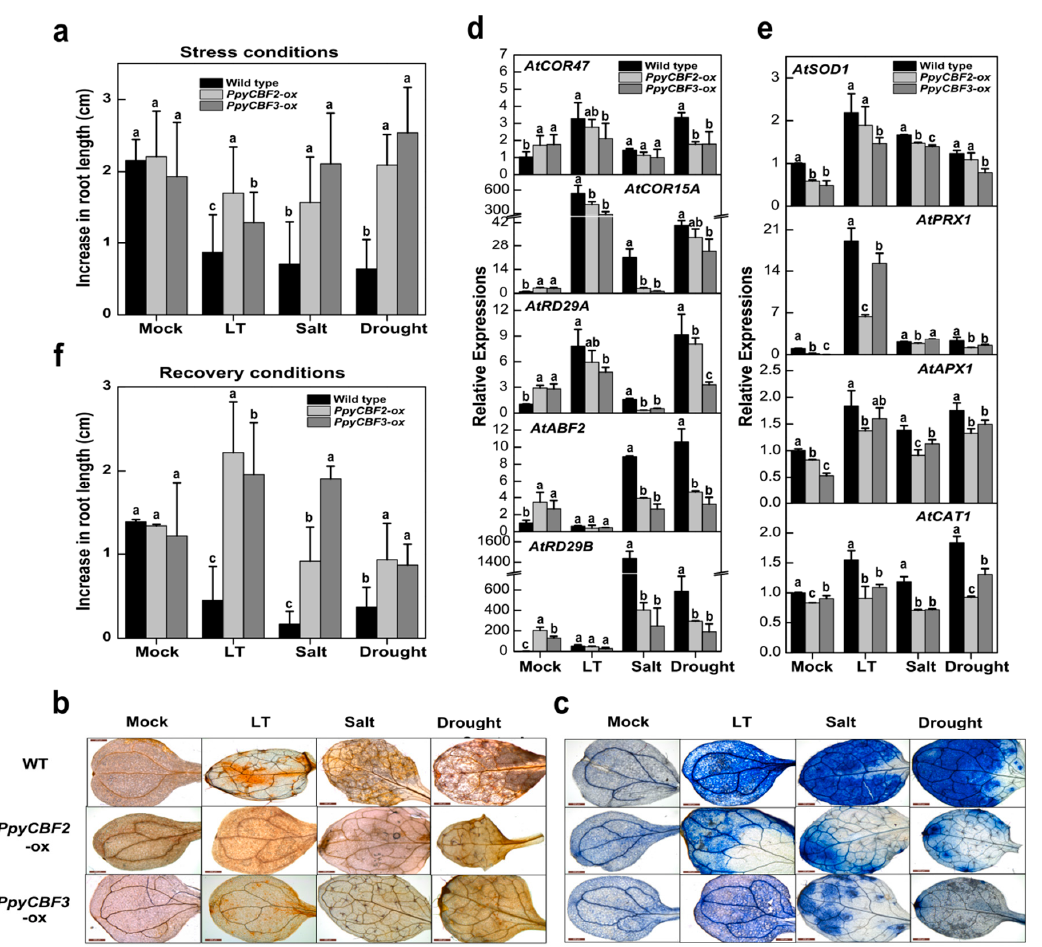
Figure 4. Overexpression analysis of PpyCBFs 2 and 3 in Arabidopsis during abiotic stresses. ( a ) Increase in root length (cm) of wild type (WT) and overexpressed lines during low temperature (LT), salt, and drought treatments by using ImageJ software. Error bars indicate standard errors from three biological replicates. ( b , c ) Diaminobenzidine (DAB) and nitroblue tetrazolium (NBT) staining of WT and overexpressed leaves after abiotic stresses to check ROS accumulation where brown and blue spots indicate the presence of H 2 O 2 and O2 •− in situ while the red bar scale represent 200 µ m. ( d , e ) Endogenous gene expressions of ABA-independent ( AtCOR47, AtCOR15A and AtRD29A ), ABA-dependent ( AtABF2 and AtRD29B ) and antioxidant genes ( AtSOD1, AtPRX1, AtAPX1 and AtCAT1 ) in WT and overexpressed lines during control and abiotic stresses, normalized to AtPP2A expression levels. ( f ) Increase in root length to monitor the recovery among overexpressed and WTs Arabidopsis under normal conditions after abiotic stresses. Error bars indicate standard error from three biological replicates. Means with different letters had significant differences ( p < 0.05).